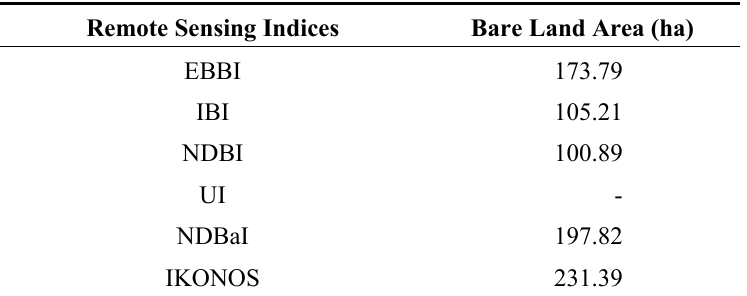
Table 4. The bare land area in Serangan Island determined using each type of index/remote sensing data